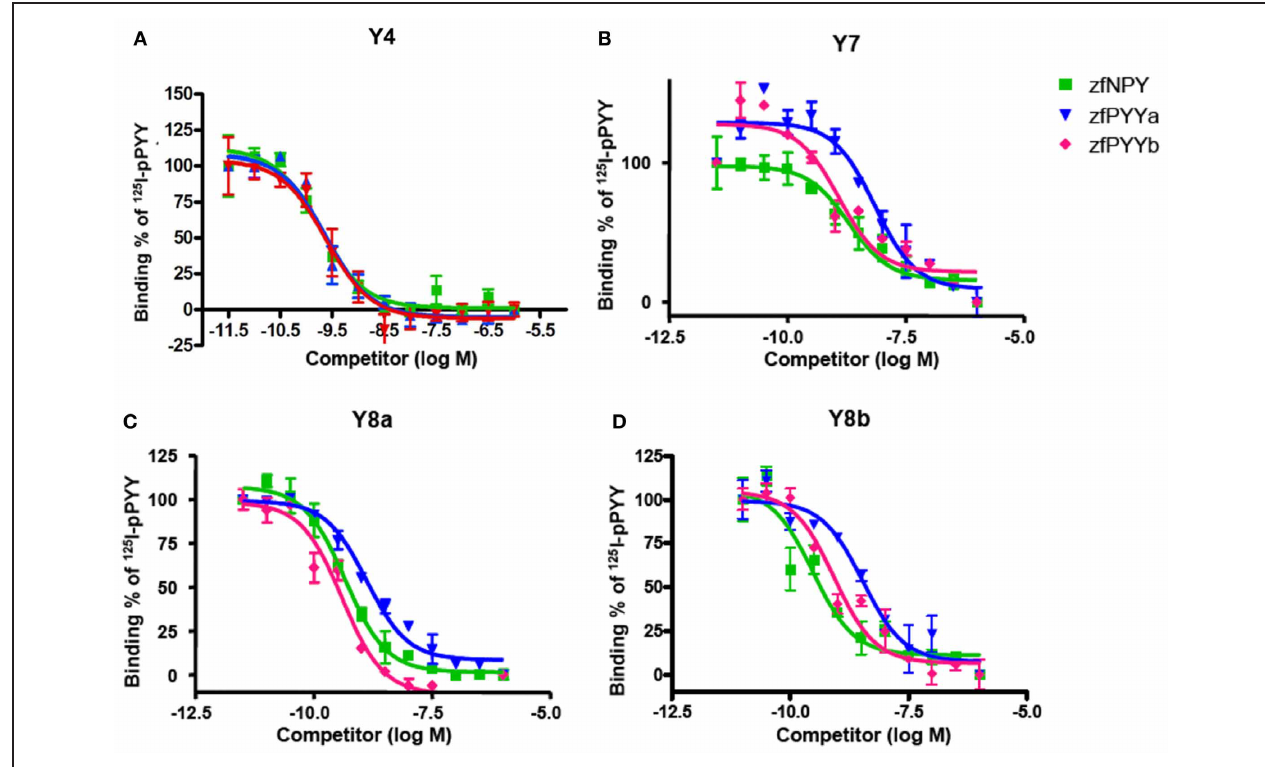
FIGURE 2 | Binding curves for each receptor. Panels (A–D) are the representative binding curves for Y4, Y7, Y8a and Y8b, respectively. The x -axis is the logarithmic concentration of unlabeled ligand. All experiments